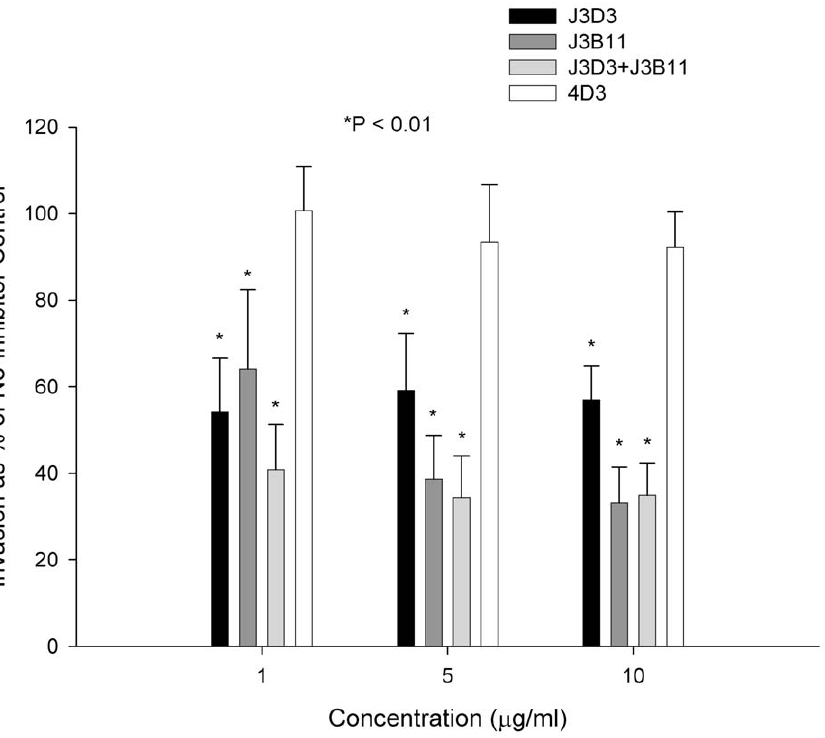
Figure 3. Effect of combined monoclonals on sialic acid-independent invasion of 7G8. Monoclonals J3B11 and J3D3 were used singly or in combination. When used in combination, each monoclonal was used at half of the total concentration. 4D3 is a negative control antibody that recognizes red cell CD55. P values are for the comparison to the no-inhibitor control using Dunnett’s pairwise multiple comparison t-test using matching by experiment date. Parasitemia was determined using flow cytometry. The figure represents a summary of 3 experiments. Bars are means 6 standard deviations.